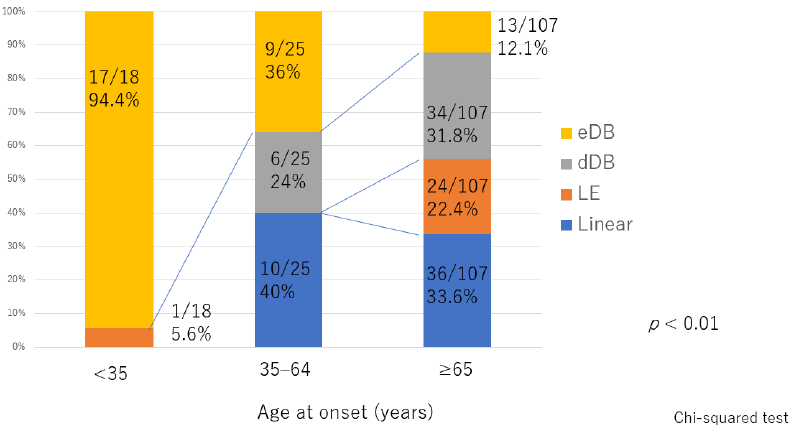
Figure 4. Distribution of indocyanine green pattern according to age of onset. The between-group difference was statistically significant. dDB, distal dermal backflow; eDB, extended dermal backflow; LE, low enhancement.